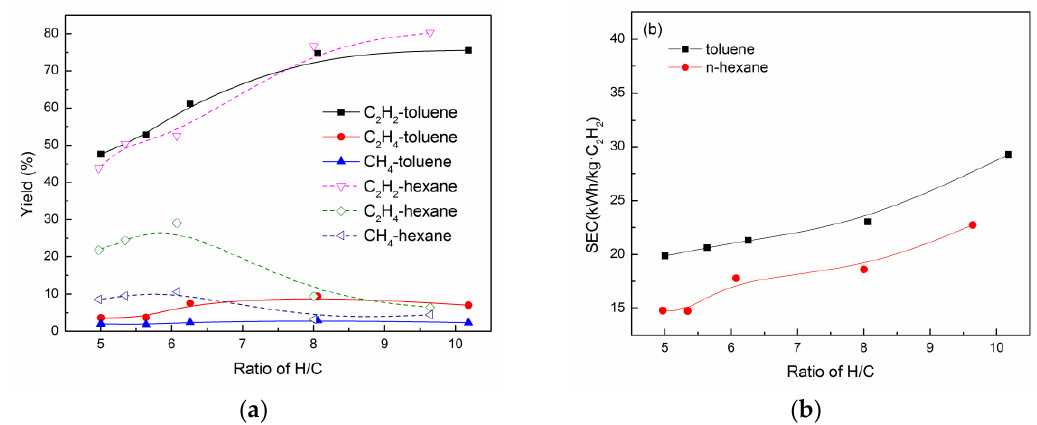
Figure 4. ( a ) The effect of H/C mole ratio on the yield, and ( b ) SEC of C 2 H 2 . Reaction conditions: Q H = 5.0 Nm 3 /h, I = 80 A, P = 14.5 kW, B = 0.058 T, m- n- hexane = 15.0–42.0 g/min, m-toluene = 10.0–25.0